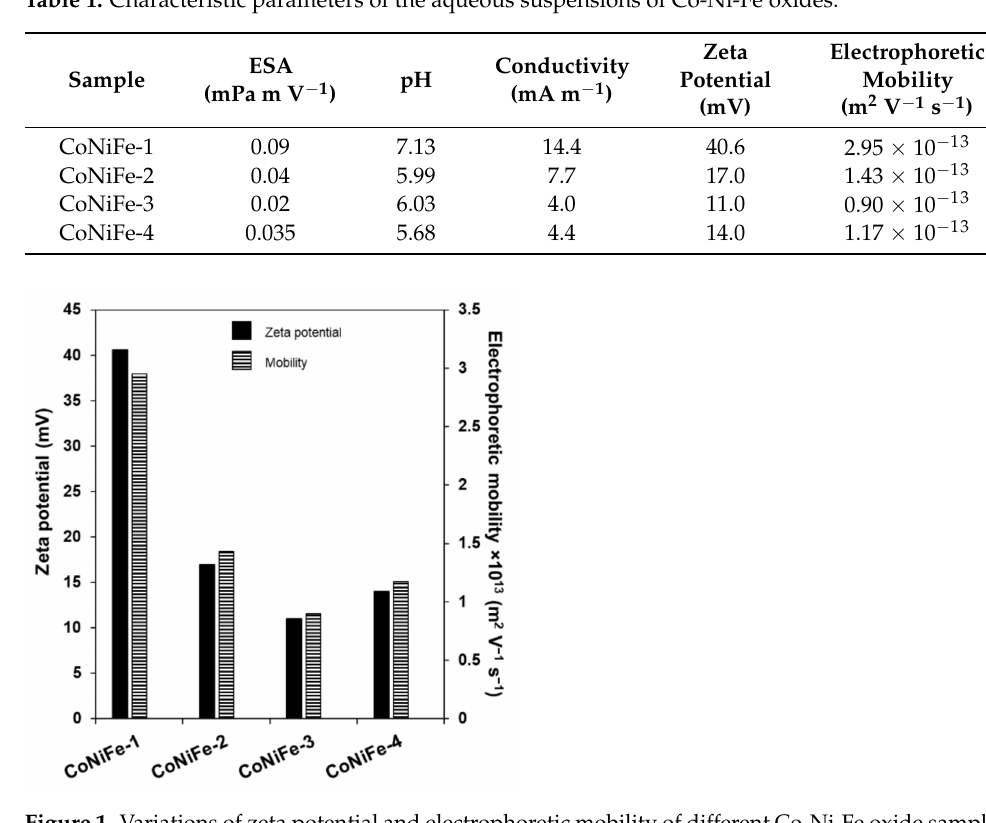
Figure 1. Variations of zeta potential and electrophoretic mobility of different Co-Ni-Fe oxide samples in